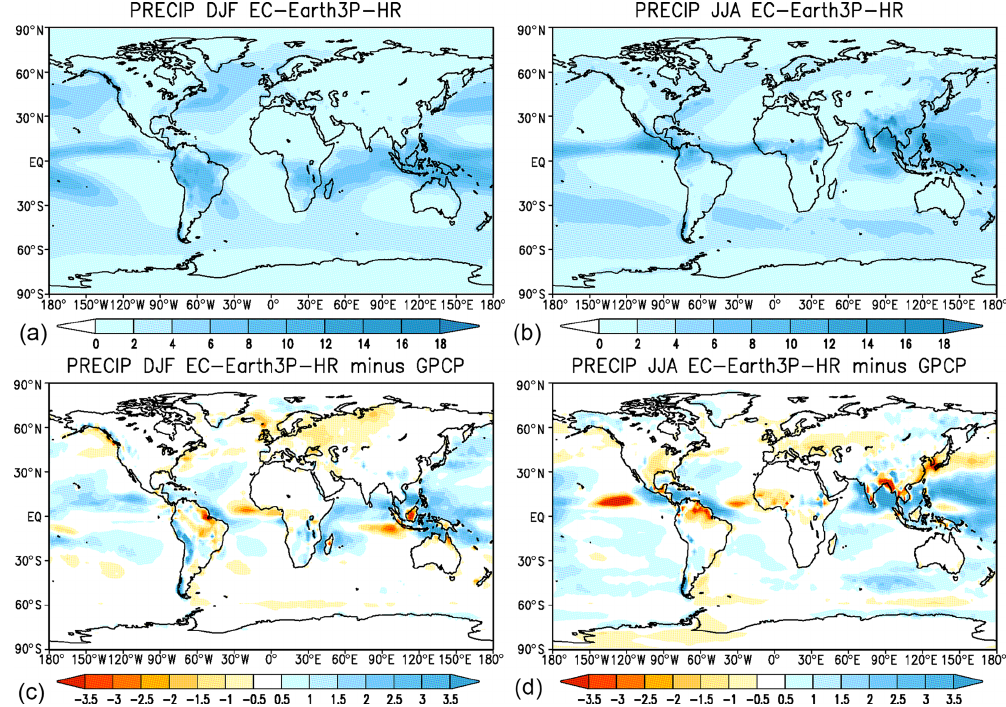
Figure 8. Precipitation and bias of EC-Earth3P-HR with respect to GPCP (mmd − 1 ) for the period 1979–2014: (a, c) DJF and (b, d) JJA. Global means of precipitation for EC-Earth3P-HR are 2.91 (DJF) and 3.25 (JJA), and for ERA5 2.70 (DJF) and 2.71 (JJA). RMSEs of EC-Earth3P-HR with respect to ERA5 are 1.06 (DJF) and 1.44 (JJA).